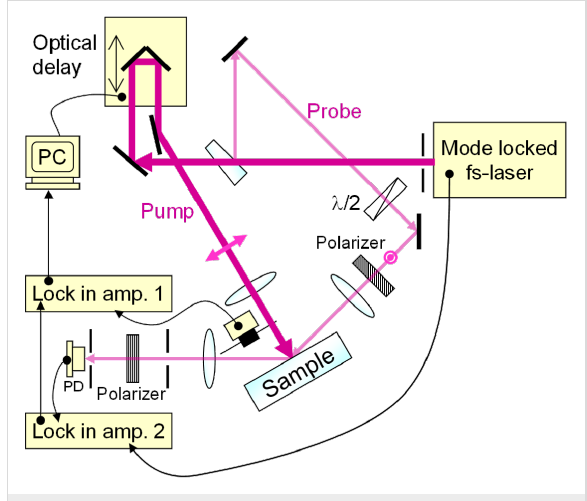
Figure 3: Schematic diagram of pump–probe experimental set-up.